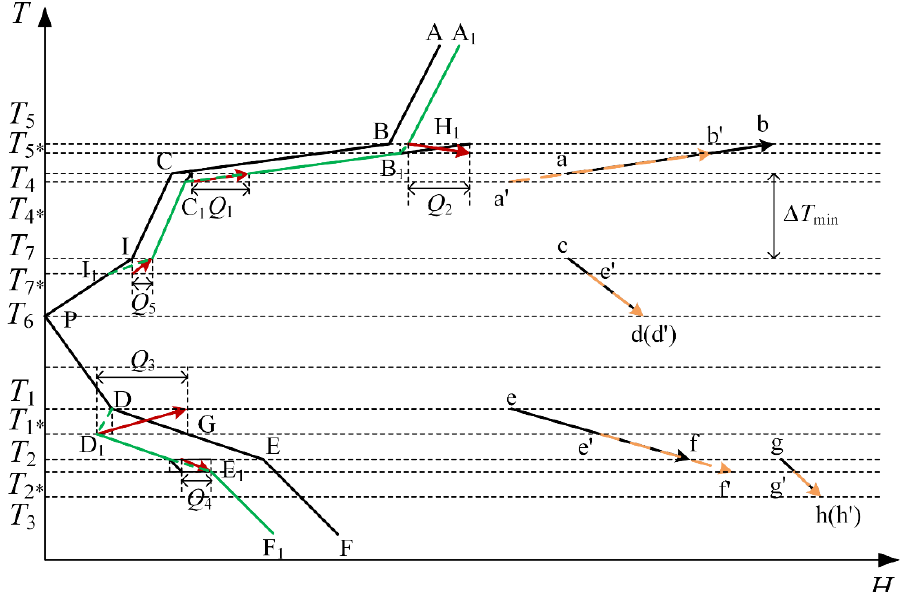
Figure 3. Variation of GCC for Case 2. Table 2. Changes of the pinch temperature and hot utility for Case 2